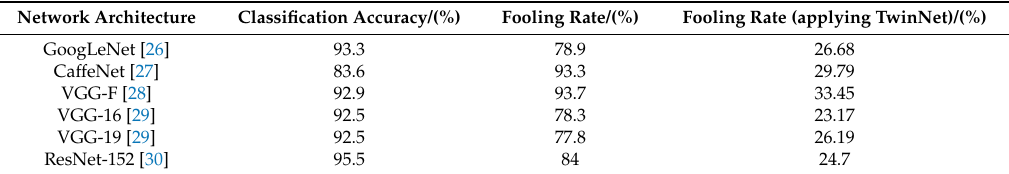
Table 2. Classification accuracy of six network architectures on normal examples and the fooling rate that the UAP reached before and after applying the TwinNet framework.